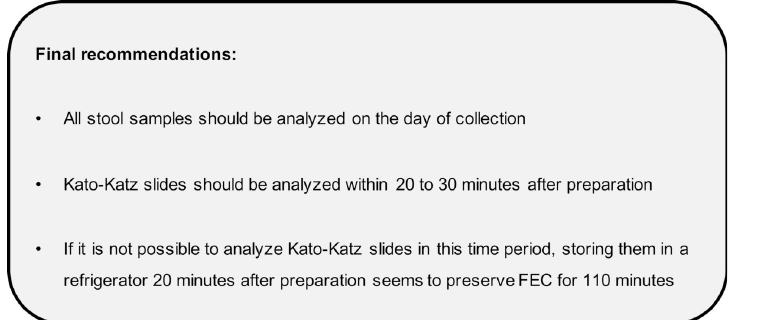
Fig 7. Final recommendations on the procedure of the Kato-Katz